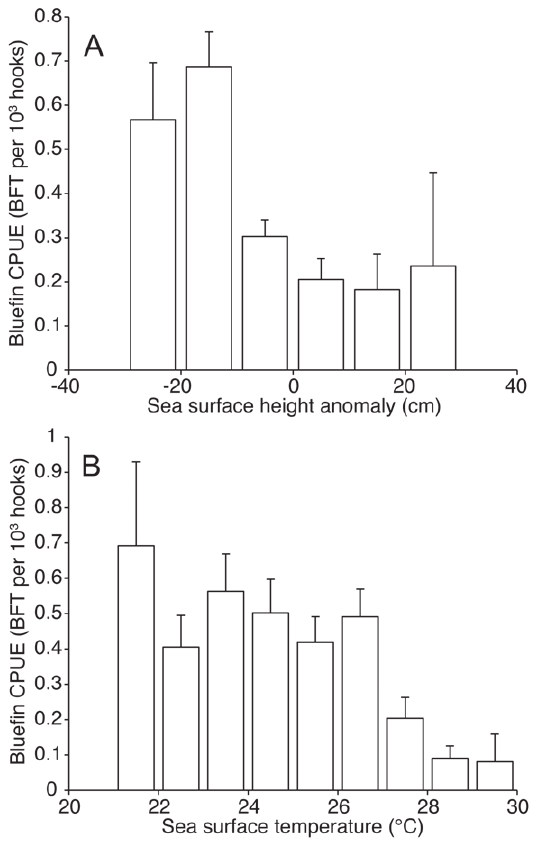
Figure 6. Annual bluefin and yellowfin tuna CPUE. Histograms show annual mean catch per unit effort (CPUE) of (A) bluefin and (B) yellowfin tuna in the Gulf of Mexico, from 1993 to 2005. Error bars indicate 1 sd (based on 1000 bootstrap samples).